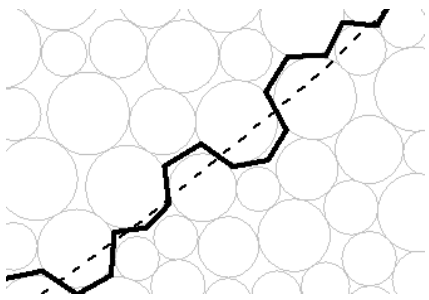
Figure 11. The enlarged drawing of the sliding surface and the corresponding edges characterizing it.